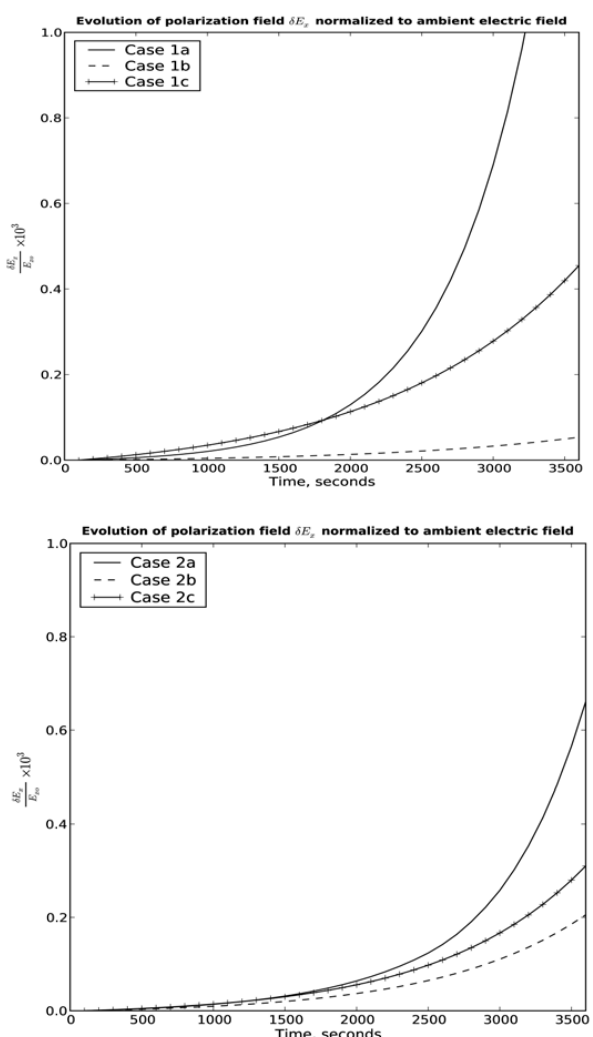
Fig. 5. Top panel: the time evolution of the zonal component of the polarization electric field, δE x , controlled by γ R and gravity wave winds for the three cases discussed in the text as follows: the solid curve represents the result corresponding to the input parameters for the evening of 23 October in which the GW strength is δ W 0 (Case 1a); the dash curve shows the results from input parameters for 24 October except that the GW characteristics are those of 23 October (Case 1b); and the line with “+” curve is the result when the gravity wave contribution in the Case 1b curve was increased to cor- respond to that observed on 24 October, with δW =3 δW 0 (Case 1c). Bottom panel: the results similar to that of the top panel but for the day pair 2 and 5 October. The solid curve represents the result corresponding to the input parameters for the evening of 2 Octo- ber in which the GW strength is δ W 0 (Case 2a); the dash curve shows the results from input parameters for 5 October except that the GW characteristics are those of 2 October (Case 2b); the line with “+” curve is the result when the gravity wave contribution in the Case 2b curve was increased to correspond to that observed on 5 October, with δW =4 δW 0 (Case